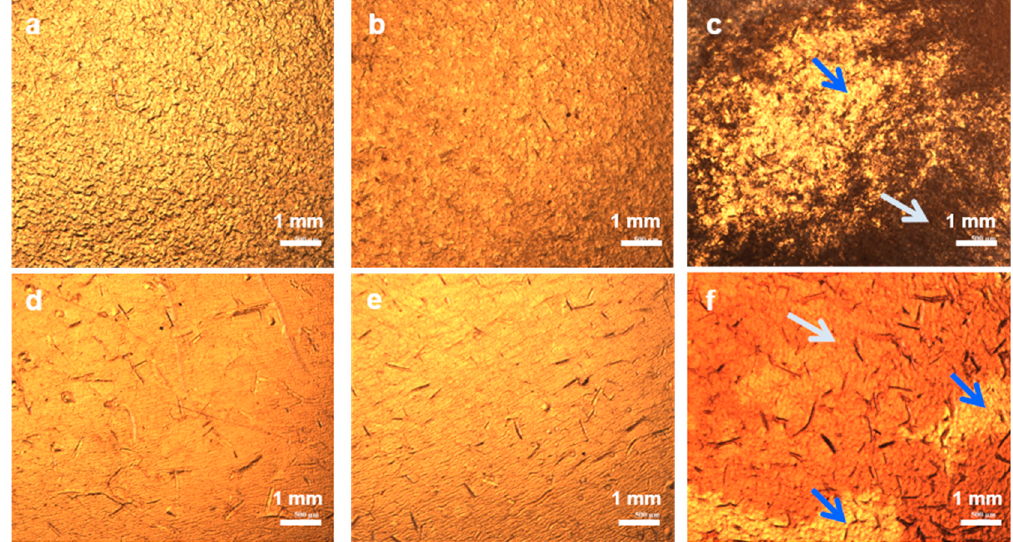
Figure 6. Optical microscopy images of CNF- and CNC-reinforced biocomposites. ( a ) T1F3_CNF, ( b ) T1F6_CNF, ( c ) T1F9_CNF, ( d ) T1F3_CNC, ( e ) T1F6_CNC, and ( f ) T1F9_CNC. (The two different phases: the lighter (soft) phase and the darker phase (rigid) are indicated by the blue and white arrows, respectively.)